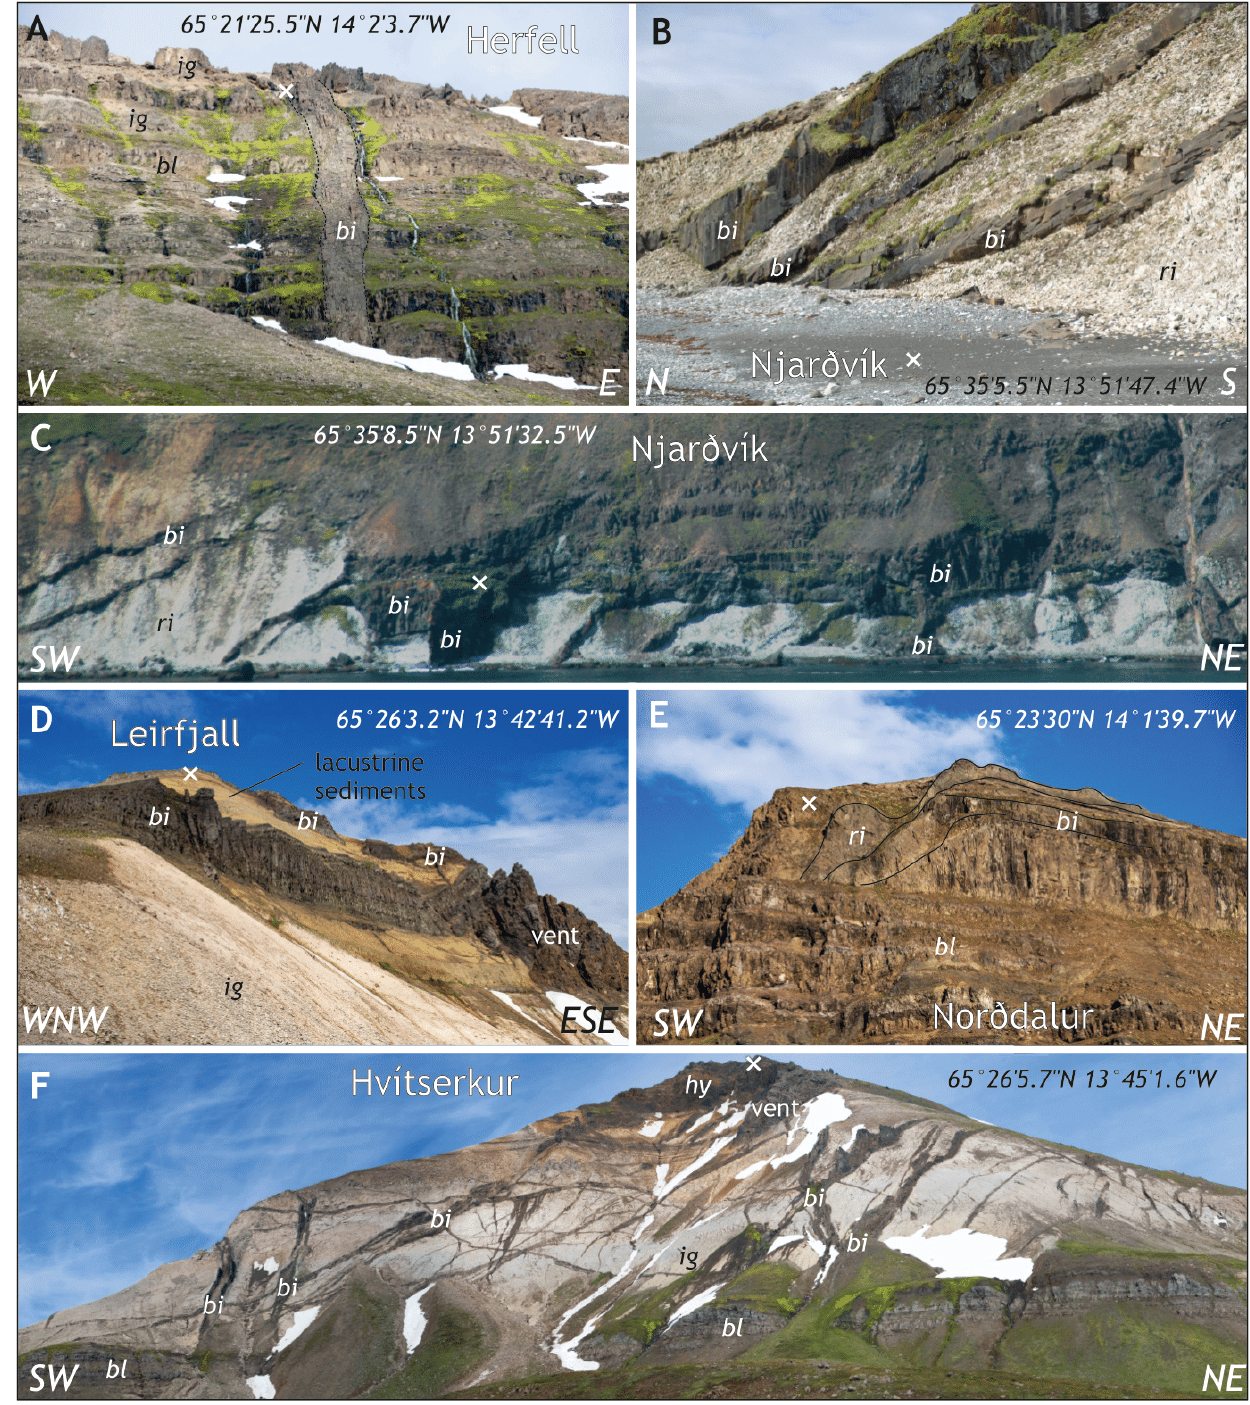
Figure 12: Annotated field photographs of magmatic intrusions in BEL. Abbreviations: b = basalt, r = rhyolite, hy = hyaloclastite, l = lava, i = intrusion, ig = ignimbrite. × marks the location of the coordinates mentioned in each photograph. [A] Regional dyke crosscutting basaltic lavas and rhyolitic ignimbrites on the south flank of Herfell. Thickness of the dyke is approximately 5 m. [B] Basaltic inclined sheets crosscutting the white subvolcanic rhyolite of the Njarðvík intrusive complex at the shore of Njarðvík. Middle sheet is about 0.5 m thick. [C] The Njarðvík sill fed by inclined sheets crosscutting the white subvolcanic rhyolite of the Njarðvík intrusive complex at the shore of Njarðvík. See Burchardt [2008] for details. [D] Basaltic sills, dykes and vent in the yellow-brown lake sediments of the Breiðuvík caldera. See Section 4.5.3 for a detailed description of the caldera. [E] Dyke and sill in the basaltic lavas on the northern end of Norðdalur. [F] Basaltic dykes cutting the Hvítserkur ignimbrite of the Breiðuvík caldera. See Section 4.5.3 for a detailed description of the